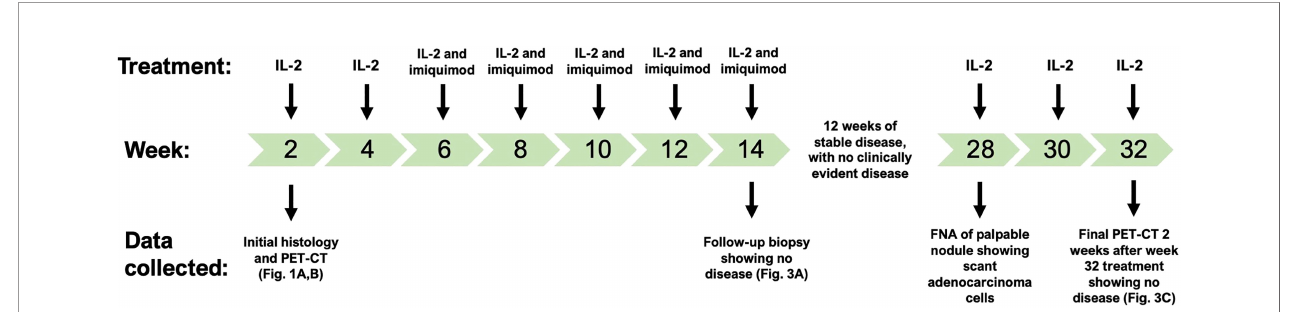
FIGURE 2 | Treatment timeline for intralesional IL-2 injections and topical imiquimod. The patient was initially treated with IL-2 monotherapy, but showed only a partial response, after which imiquimod was added. The initial histology and PET-CT ( Figure 1 ) were collected at week 2, the fi rst treatment. Following 12 weeks of clinical stability with no evidence of disease, an FNA positive for adenocarcinoma led to three more IL-2 treatments, which lead to a complete clinical and radiological response ( Figure 3 ).